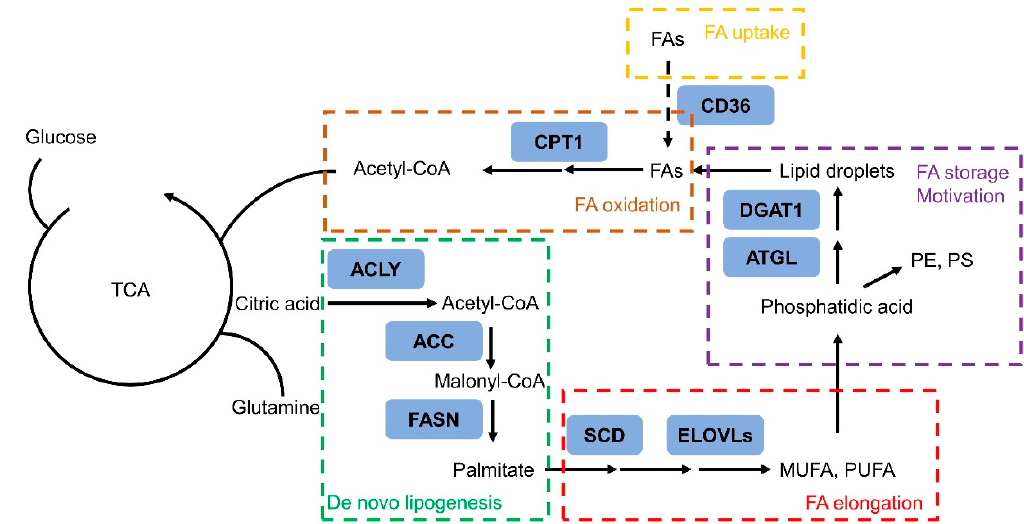
Figure 2. Schematic diagram of the rewiring of fatty acid metabolism in prostate cancer cells. Tricarboxylic acid cycle—TCA; mono-unsaturated fatty acid—MUFA; poly-unsaturated fatty acid—PUFA; fatty acid—FA; phosphatidylethanolamine—PE; phosphatidylserine—PS.